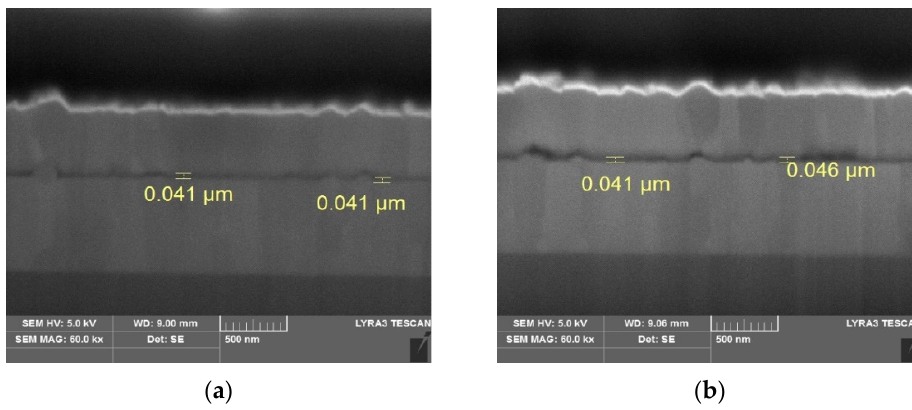
Figure 3. Ga-FIB-SEM images of MEH-PPV film obtained by ( a ) spin coating and ( b ) molecular ordering coating methods.